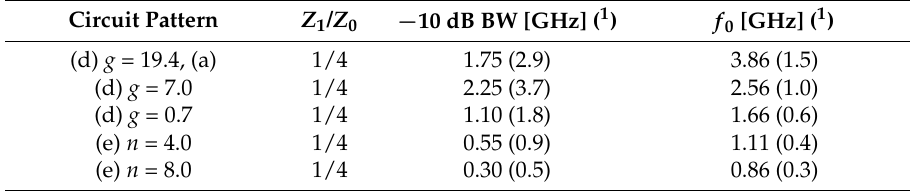
Figure 9. Measured | S 21 | and | S 11 | results of rectangular stubs of Z 1 / Z 0 = 1/4 with different series inductances, as shown in Figure 5d. Table 2. Stop bandwidth in the case of rectangular stubs with the series inductance.